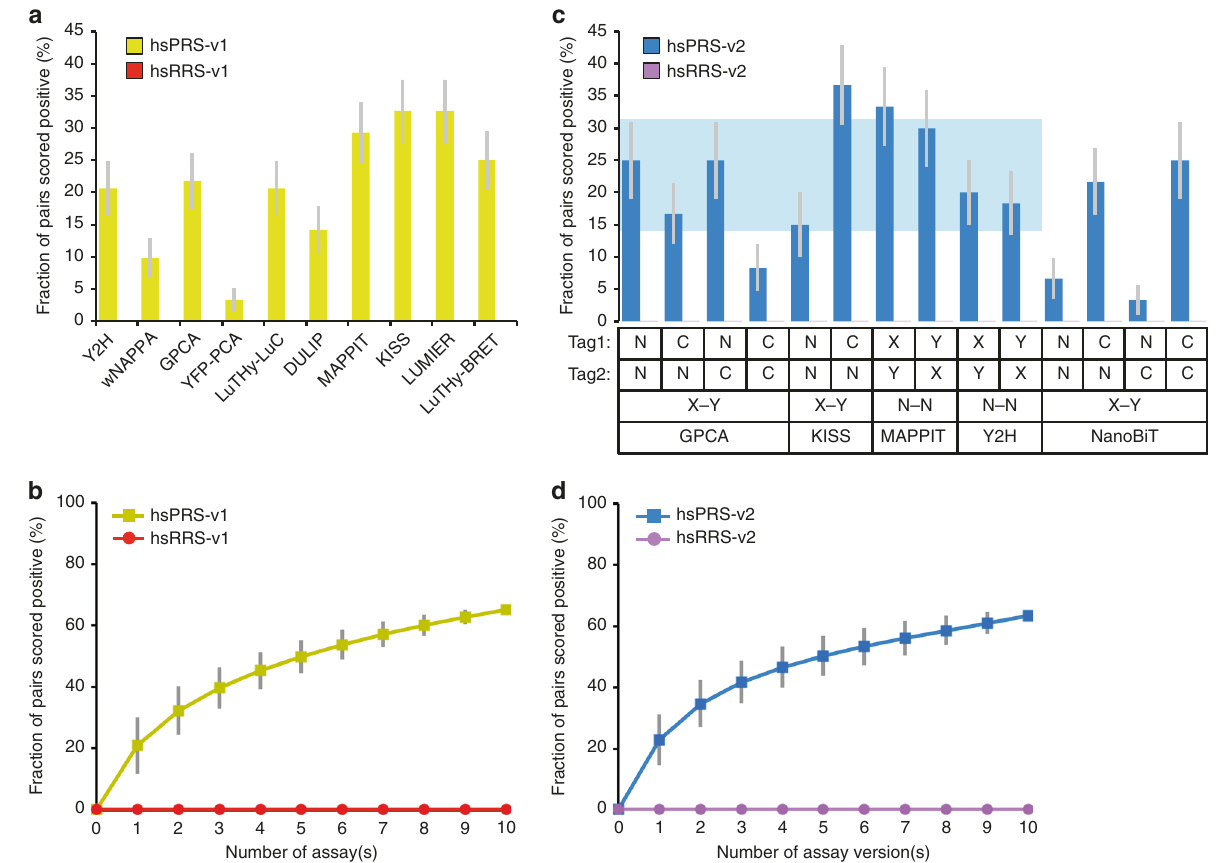
Fig. 2 Recovery of positive control PRS pairs by multiple assays or assay versions. a Fractions of hsPRS-v1 pairs recovered by ten well-established assays when an identical threshold of no hsRRS-v1 pairs scoring positive is applied. b Cumulative hsPRS-v1 recovery rates when assays in ( a ) are combined (individual data points are displayed in Supplementary Fig. 1c). c Fractions of hsPRS-v2 pairs recovered by different versions of GPCA, KISS, MAPPIT, Y2H and NanoBiT when an identical threshold of no hsRRS-v2 pairs scoring positive is applied. Horizontal shaded blue area indicates the average recovery rate ± S.D. for GPCA, KISS, MAPPIT and Y2H versions. d Cumulative hsPRS-v2 recovery rates when versions of GPCA, KISS, MAPPIT and Y2H presented in ( c ) are combined (individual data points are displayed in Supplementary Fig. 2d). Error bars indicate standard errors of proportions ( a , c ) or standard deviations ( b , d